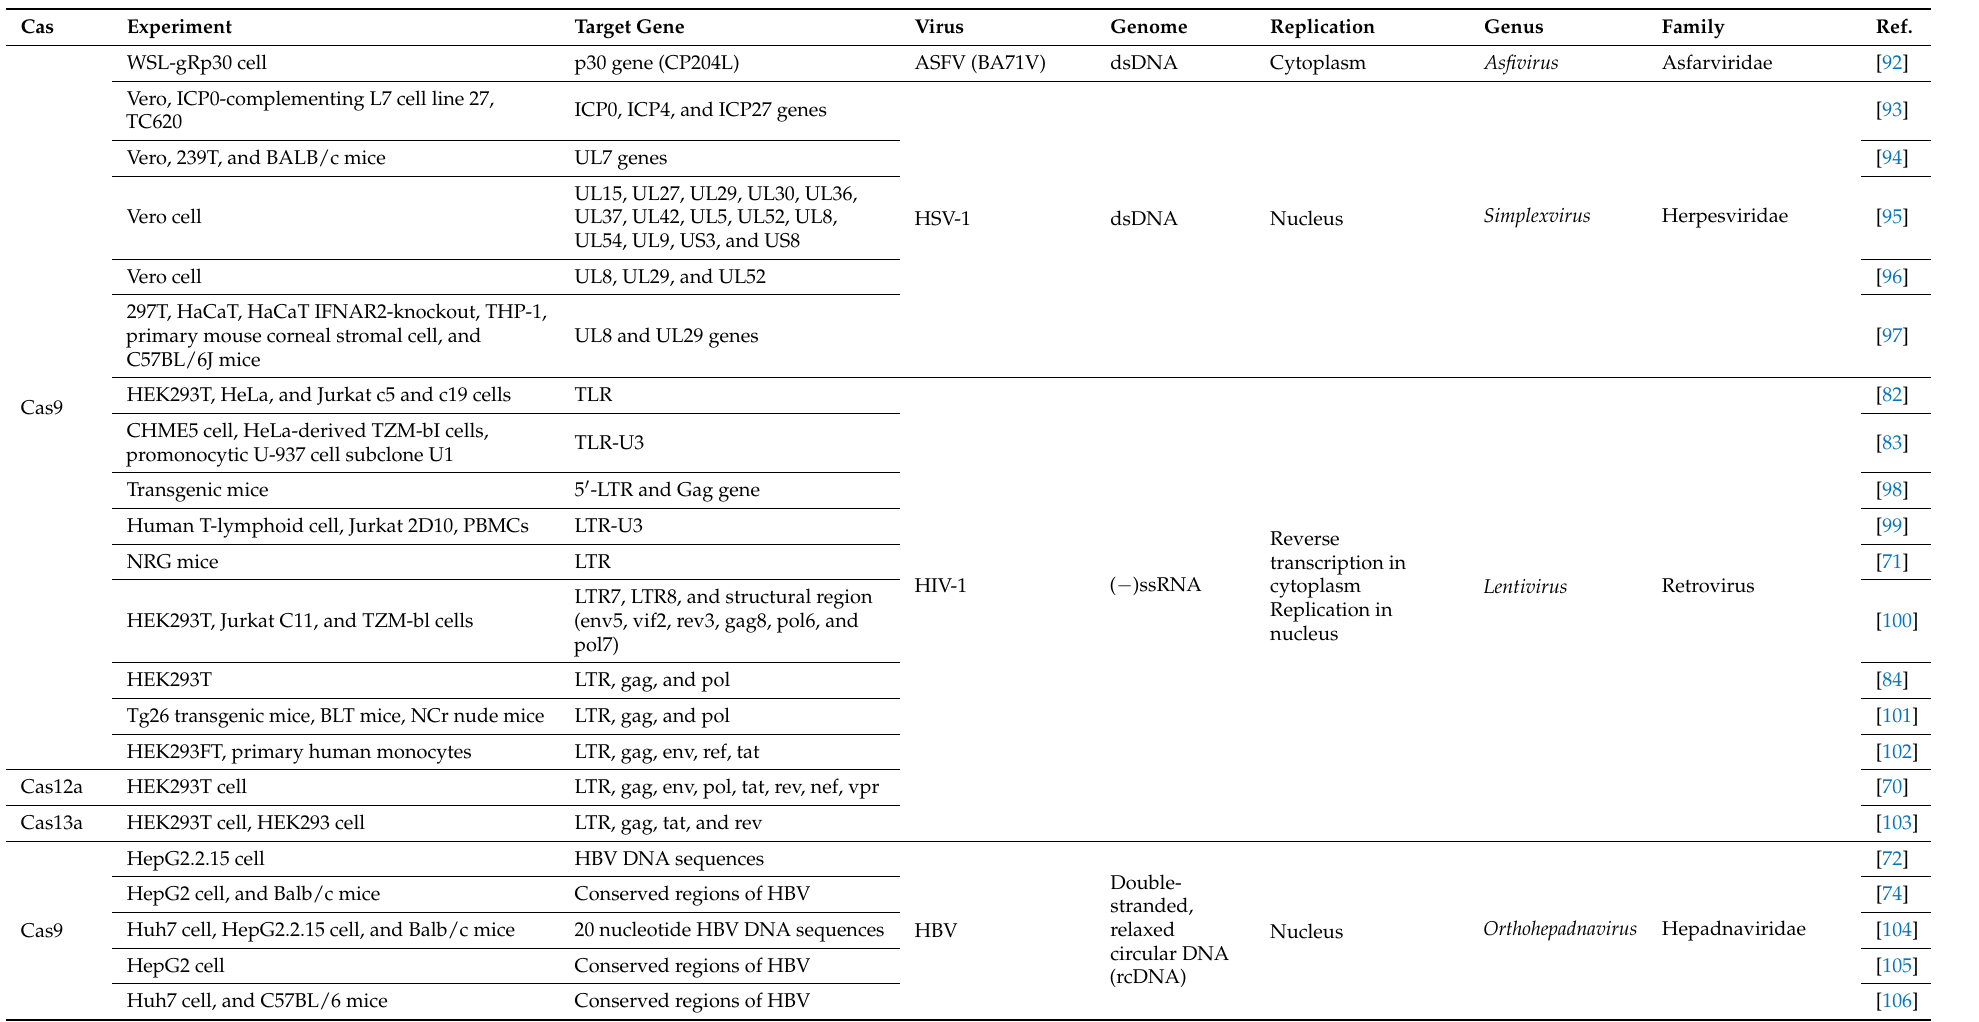
Table 3. Viral genome-specific cleavage by CRISPR with different Cas